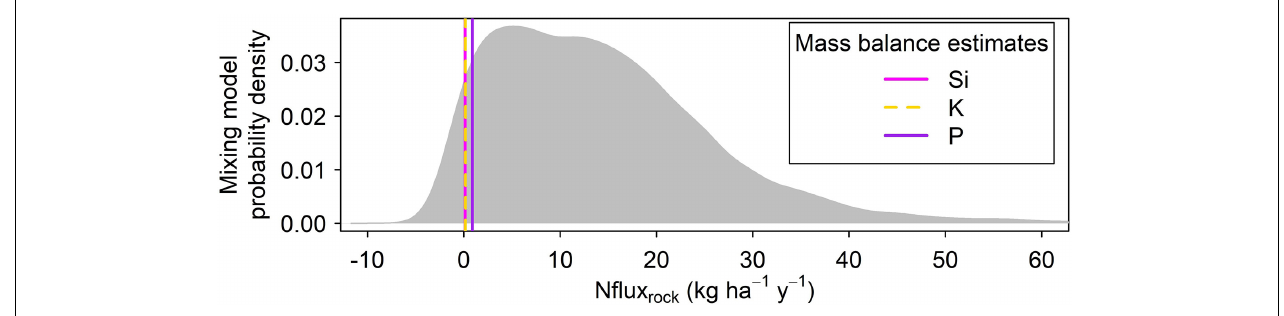
FIGURE 7 | Monte carlo simulation results. The gray probability distribution shows results from 10,000 estimates of the rock-N weathering flux based on 15 N constraints (Eq. 6), with parameters drawn randomly published ranges and values measured in this study (Methods see section “Mass-Balance-Based N Flux Estimate”). Estimates of the rock-N weathering flux based on geochemical mass balance calculations are shown for comparison with vertical lines: magenta = Si; yellow = K; purple = P. The empirical 95% confidence range of the 15 N-based estimate spans from –1.1 to 44.2 kg ha − 1 y − 1 , indicating that the range of possible rock N fluxes consistent with soil N isotopes is large and encompasses